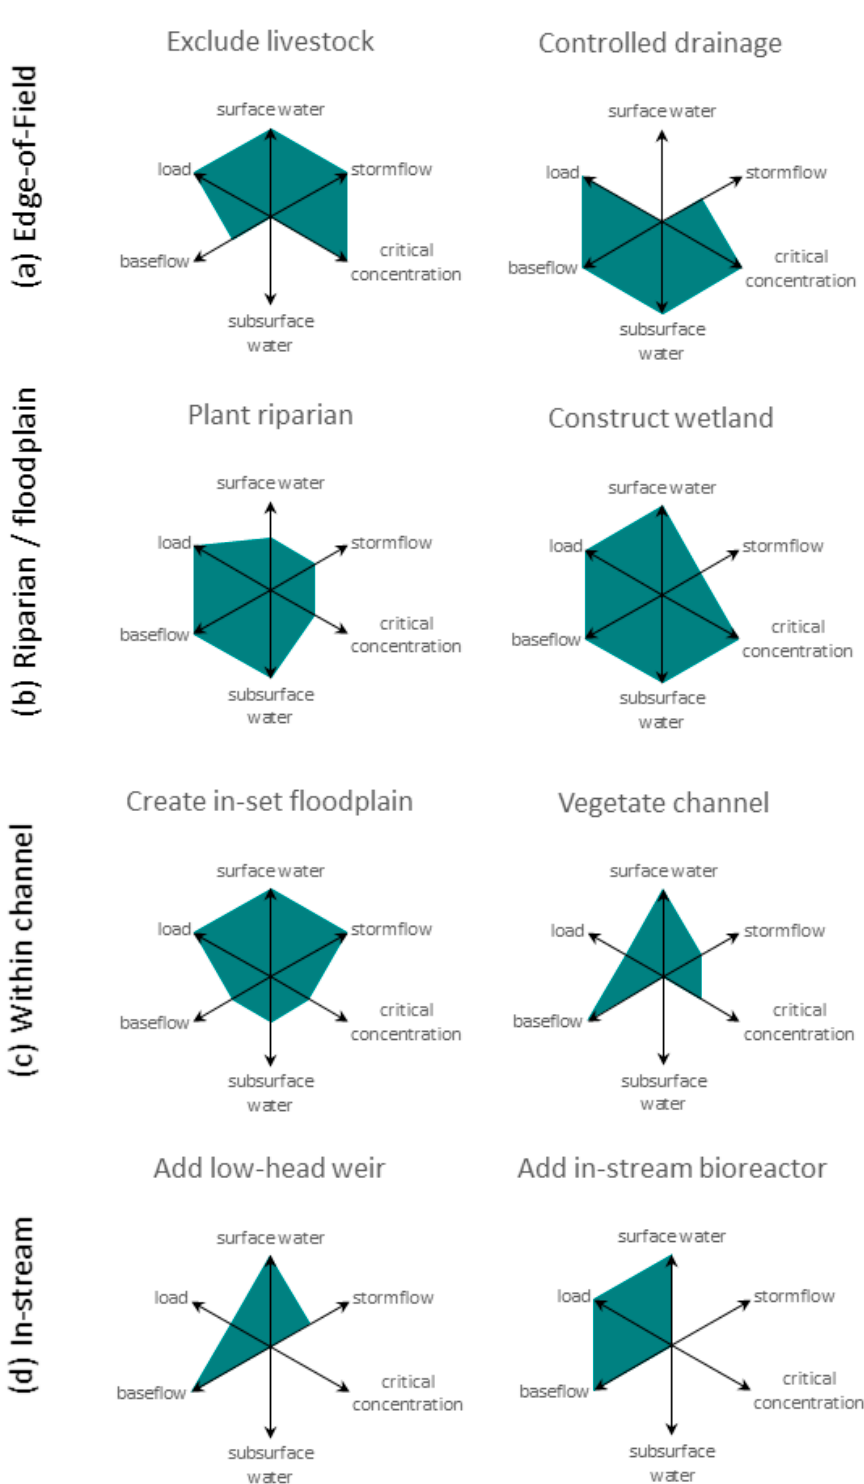
Figure 1. Potential suitability of N attenuation tool combinations across critical locations ordered from ( a ) the edge-of-field, ( b ) the riparian zone or floodplain, ( c ) within the channel margins, and finally to ( d ) in-stream. The three-axis framework (delivery pathway, timing, and change in the receiving environment) of the toolbox provides a visualization of tool stacking. Shapes denote the relative strengths for tools to target the flow pathway (surface to subsurface), timing (stormflow versus baseflow), and the effect of flux reduction on N concentration or N load in the receiving environment.